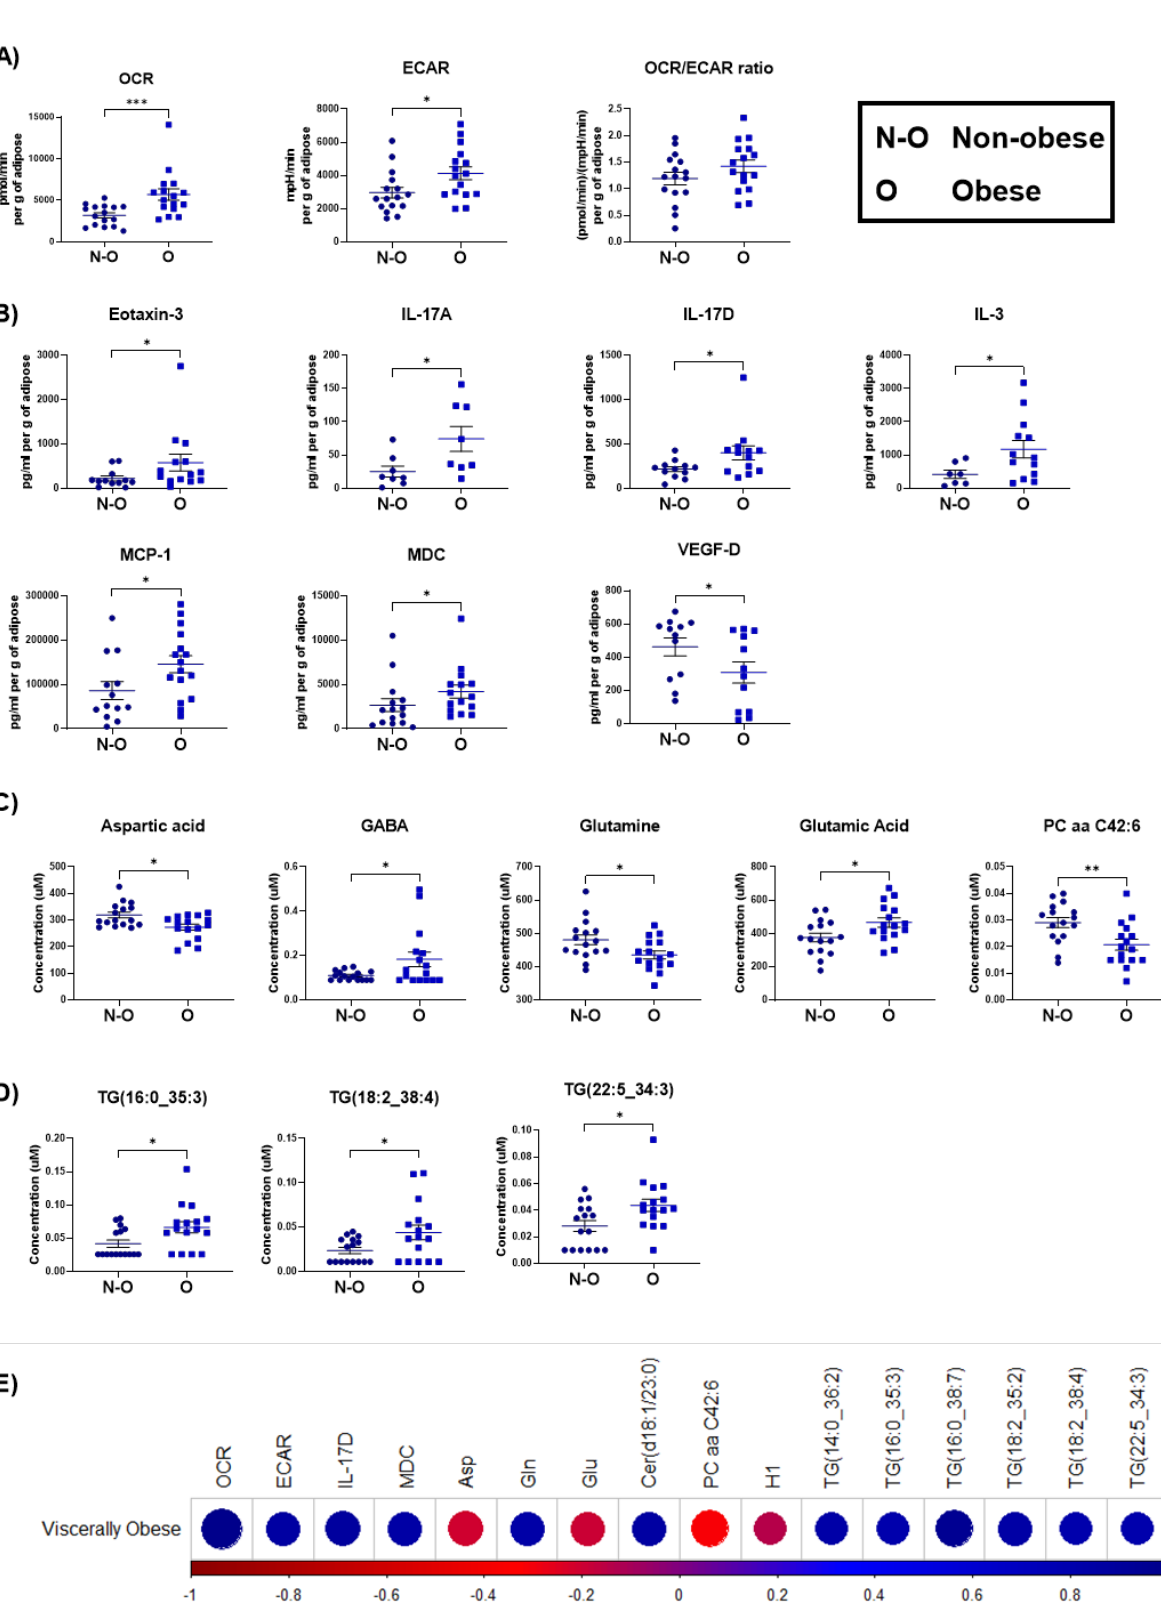
Figure 1. Altered OCR, ECAR, pro-inflammatory cytokines, and metabolites in adipose explants from obese OAC patients compared with non-obese patients. ( A ) OCR, ECAR, and OCR:ECAR ratio (Mann – Whitney test). ( B ) Eotaxin-3, IL-17A, IL-17D, IL-3, MCP-1, MDC, and VEGF-D (Mann –